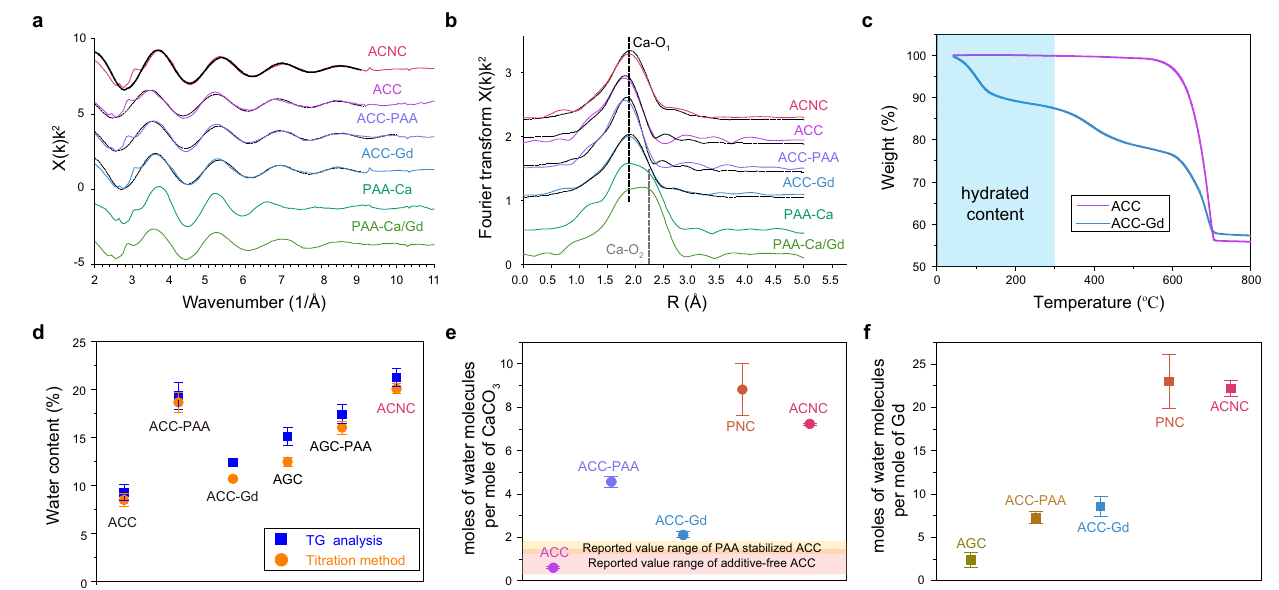
Fig. 2 | High water content of ACNC. a k 2 -weighted EXAFS and b k 2 -weighted Fourier transform of the EXAFS for the ACNC, ACC standard, ACC-PAA, ACC-Gd, PAA-Ca, and PAA-Ca/Gd. Dotted black lines are their best fi t. c Thermogravimetric curveofACCandACC-Gdlyophilizedpowderisolatedbydeionizedwaterandthen exposed to dry air for over 6 months. The weight loss before 300°C could be attributed to the loss of water. d The water contents of ACC, ACC-PAA, ACC-Gd, AGC, AGC-PAA, and ACNC according to thermogravimetric (TG) analysis and